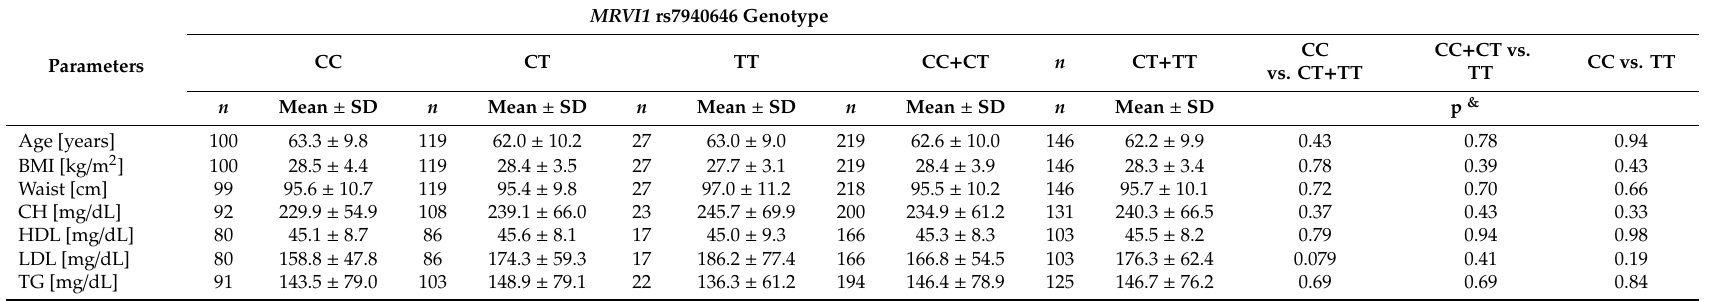
Table 4. Associations between the clinical parameters of patients with unstable angina and the MRVI1 rs7940646 genotypes.